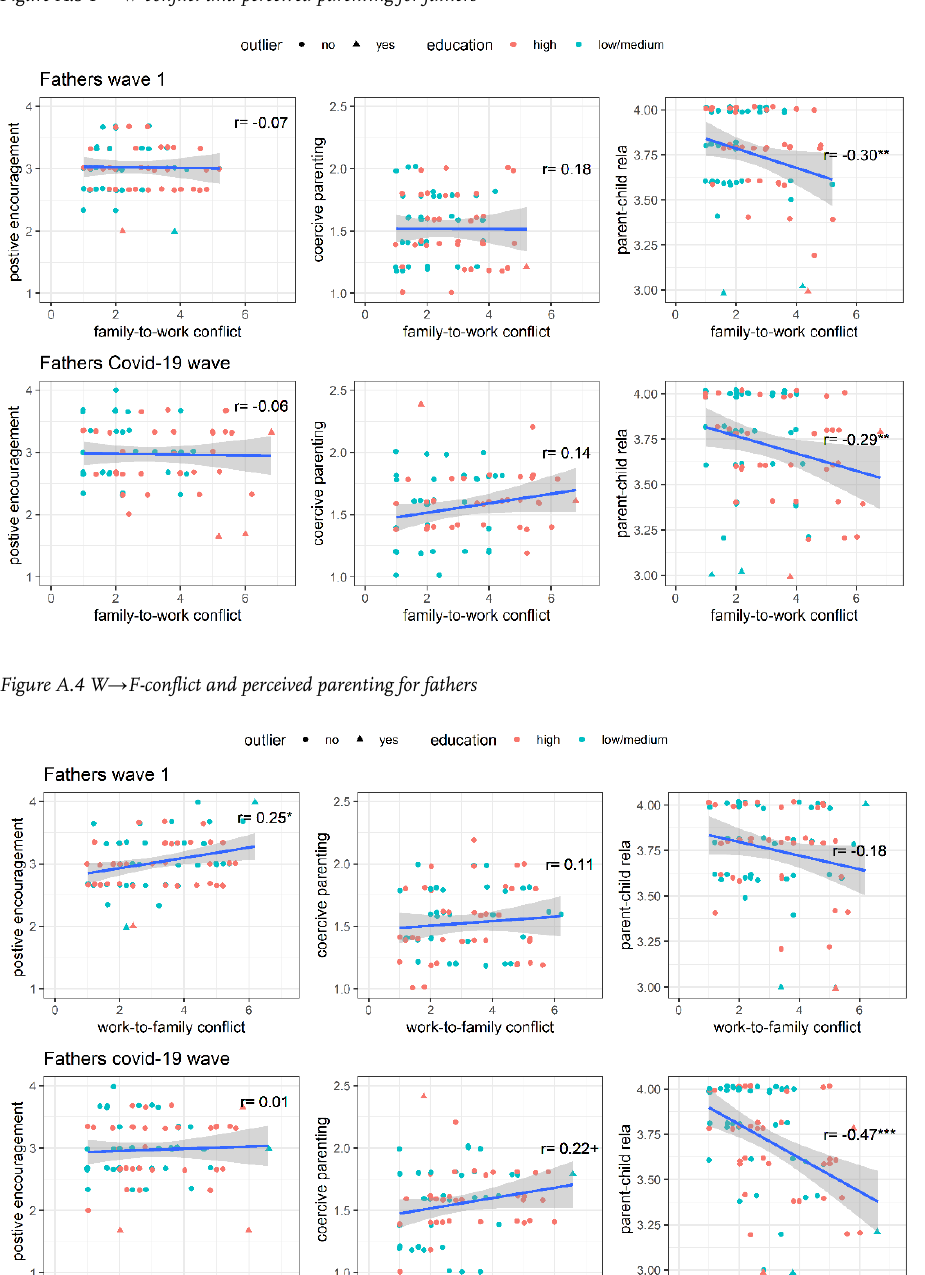
Figure A.3 F → W-conflict and perceived parenting for fathers